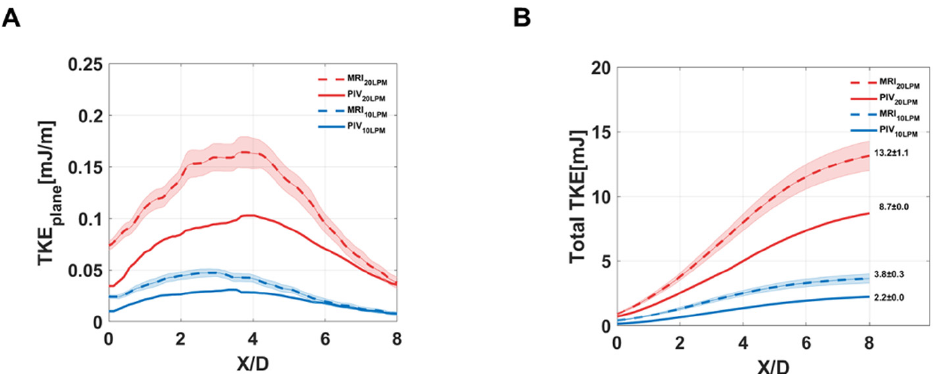
Figure 6. Planar and total Turbulence kinetic energy (TKE) through the stenosis. ( A ) Axial directional planar TKE ( B ) Axial directional accumulative total TKE.